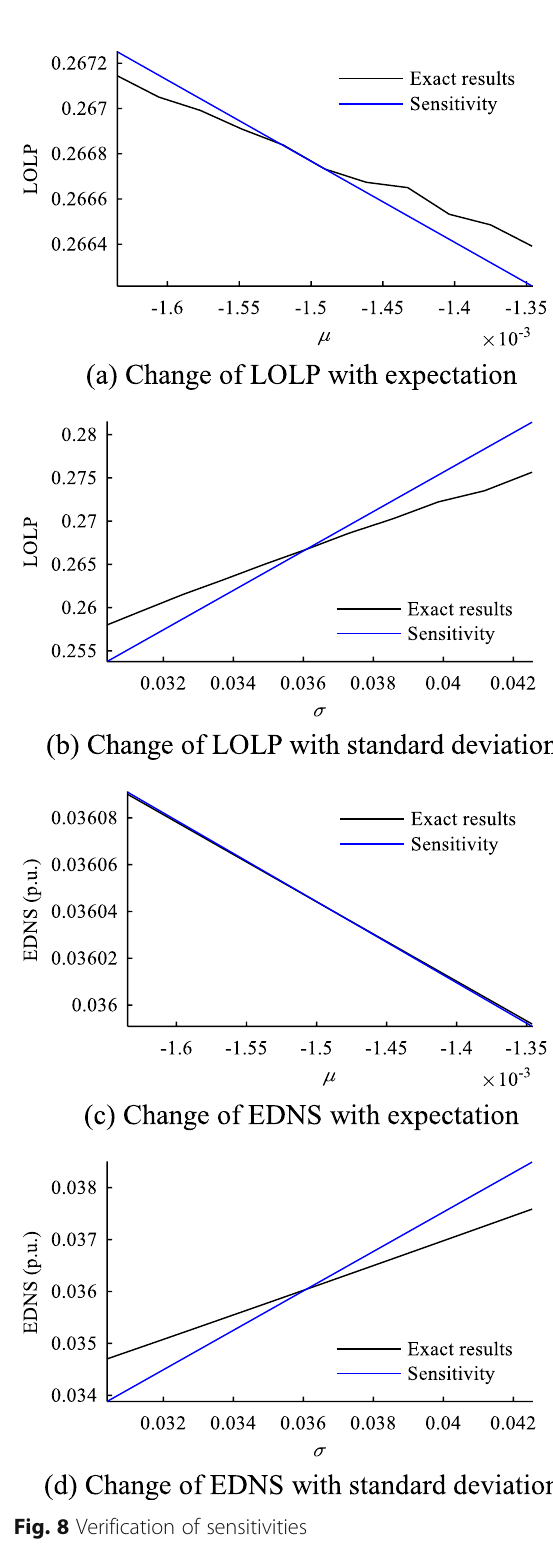
Fig. 8 Verification of sensitivities